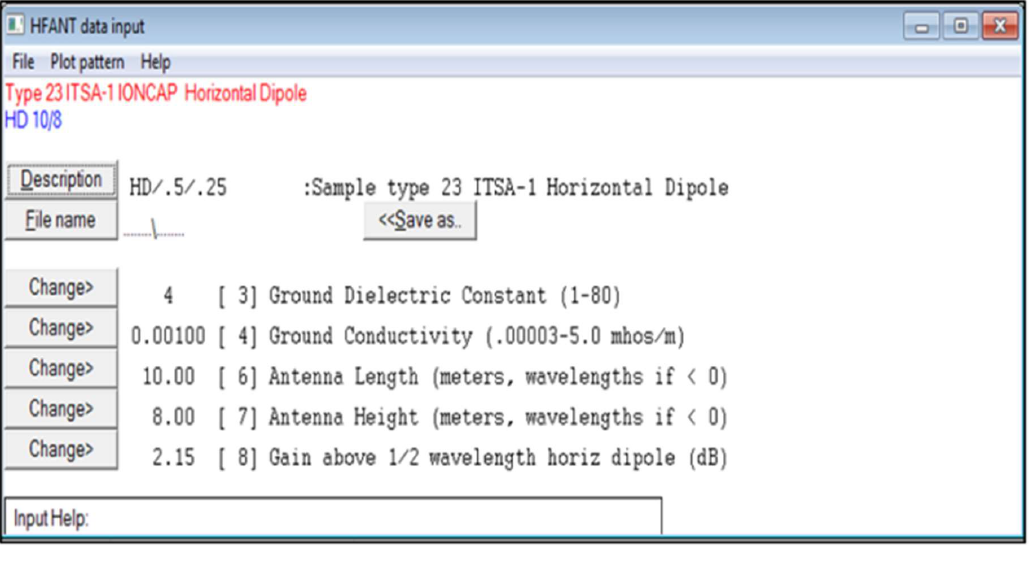
Fig. 5. Shows HFant program interface.